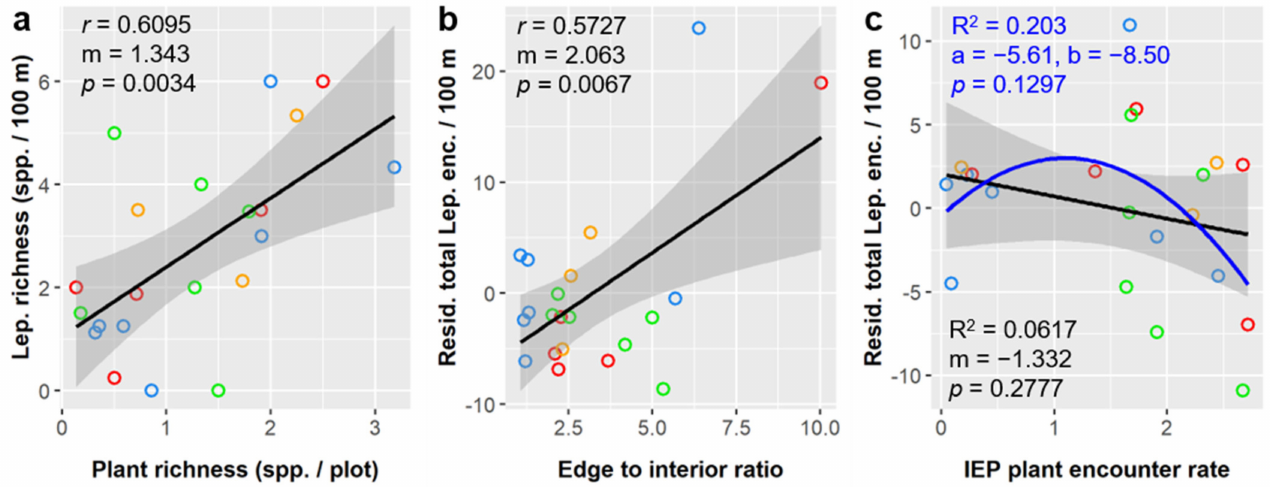
Figure 8. Linear (and nonlinear) relationships between ( a ) Lepidoptera richnness and plant richness, ( b ) residual Lepidoptera abundance (total encounters per 100 m) and edge to interior ratio, and ( c ) residual Lepidoptera abundance and and IEP plant encouter rate. Open circles denote values from one study site and are colored to denote habitat class as follows: red, S TX Disturbed Grassland; orange, Tamaulipan Lomas; green, Tamaulipan Shrubland; blue, Texas Coastal Prairies. The blue curve in panel c is the second-order polynomial best-fit line. Legend: r , Pearson correlation coefficient; m, slope from the regression model (effect size); p , p -value from the regression models shown (see main text and Table 7 for p -values from the multiple regression models); R 2 = coefficient of determination (included to compare the linear and polynomial models); a and b, polynomial equation coefficients. Table 7. Multiple regression results using Type III sums of squares examining the effects of edge to interior ratio, wind speed, IEP plant encounter rate, temperature, plant diversity, plant richness, and the natural log of the ratio of native to IEP plant encounter rate on total Lepidoptera encounters